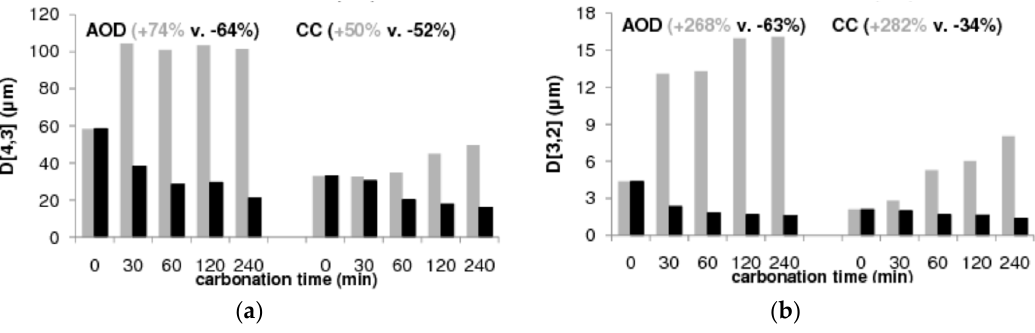
Figure 3. Average particle sizes (D(4,3) ( a ); D(3,2) ( b )) of AOD and CC slags as a function of the carbonation time with stirred and sonicated carbonation; percentage values indicate the increase or decrease figures over four hours of carbonation [22]. Re-used with permission from Elsevier (4366260475887).